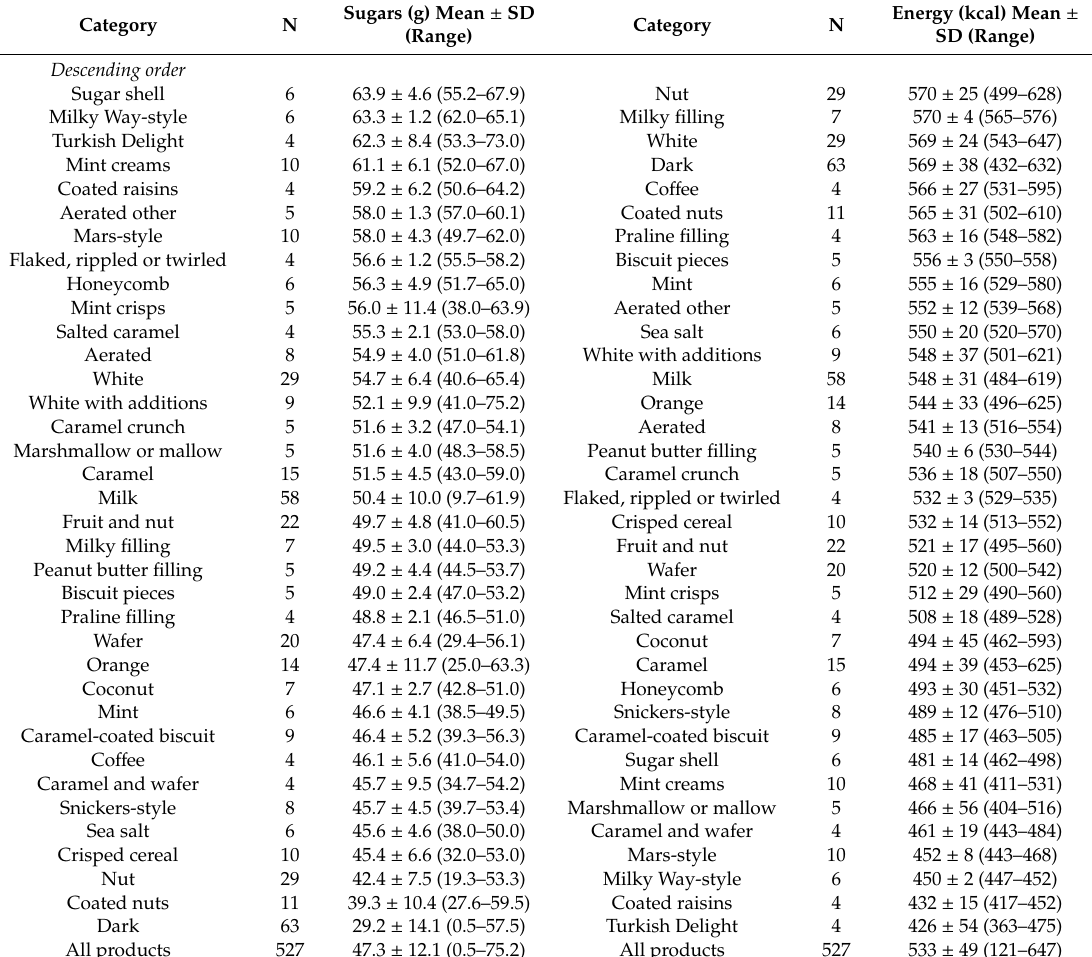
Table 3. Sugar and energy contents of di ff erent categories of chocolate confectionery per 100 g in 2017.